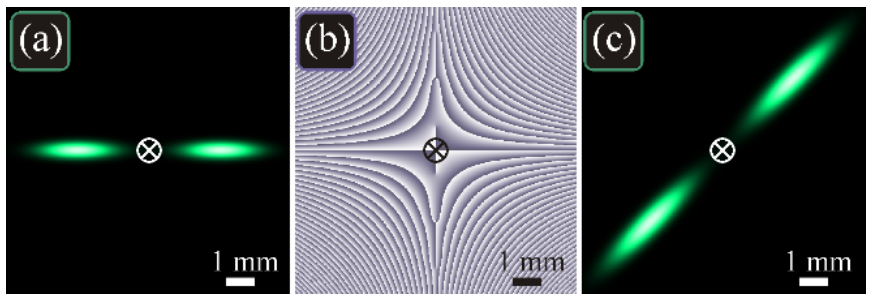
Figure 4. Distributions of intensity ( a , c ) and phase ( b ) of the propagation-invariant two-petal beam in the initial plane ( a , b ) and at the Rayleigh distance z = z 0 ( c ) for the following parameters: wavelength λ = 532 nm, waist radii of the two opposite elliptic Gaussian beams σ x = 1617 µ m and σ y = 362 µ m (i.e., w 0 = 500 µ m), positions of the beam centers ( x 0 , y 0 ) = ( ± 2.5, 0) mm, tilt angle of the major ellipse axis to the x -axis α = 0, computation domain | x |, | y | ≤ R ( R = 5 mm). The cross in the center shows the optical axis, around which the diffraction pattern rotates on propagation.